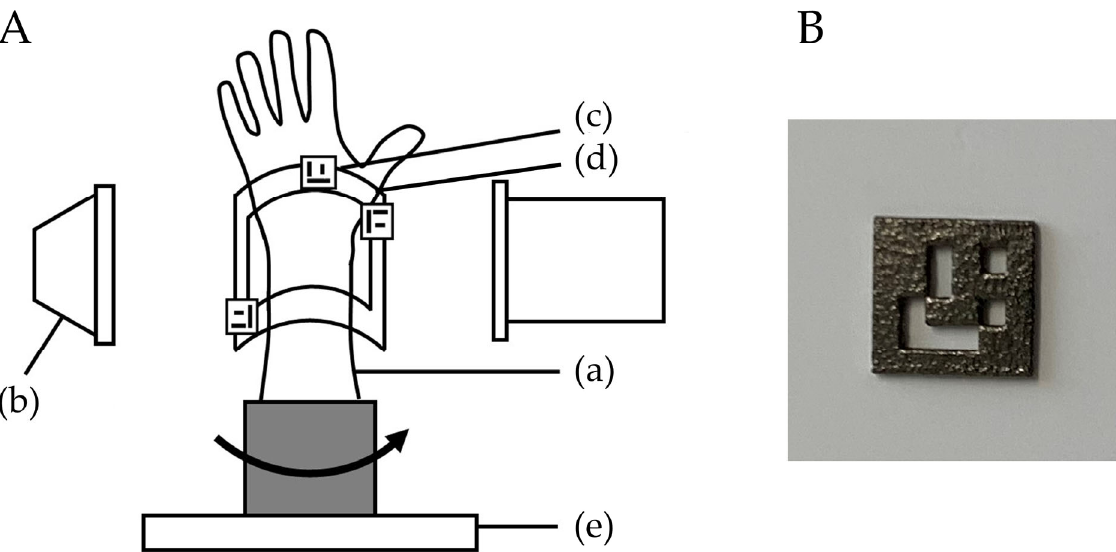
Figure 1. ( A ) Experimental se tt ing of bone model using QR code markers. ( a ) Bone model. Bone models were covered with an X-ray-transparent, elastic material that imitated skin. ( b ) Position of the image intensifier for fluoroscopy. ( c ) QR code marker. ( d ) Splint to position the markers. The splint was attached to the bone model. ( e ) Turntable to rotate the bone model. ( B ) QR code marker made of titanium.